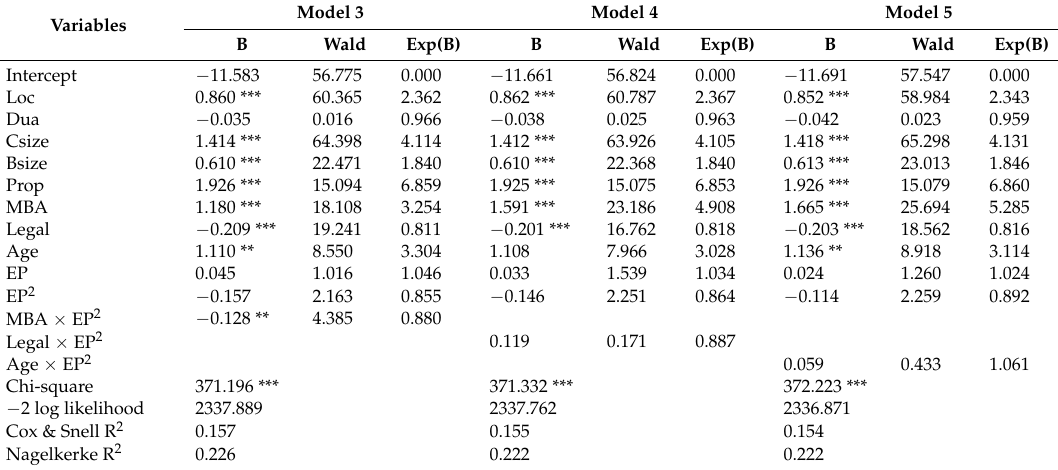
Table 3. The results of moderating